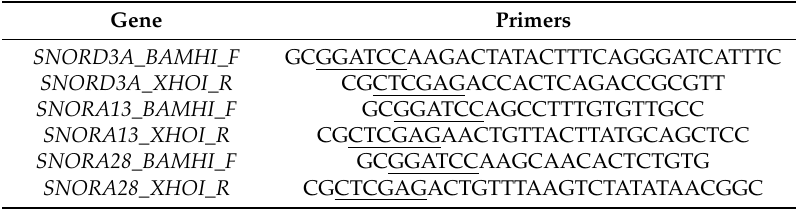
Table 1. Oligonucleotide for snoRNA expression